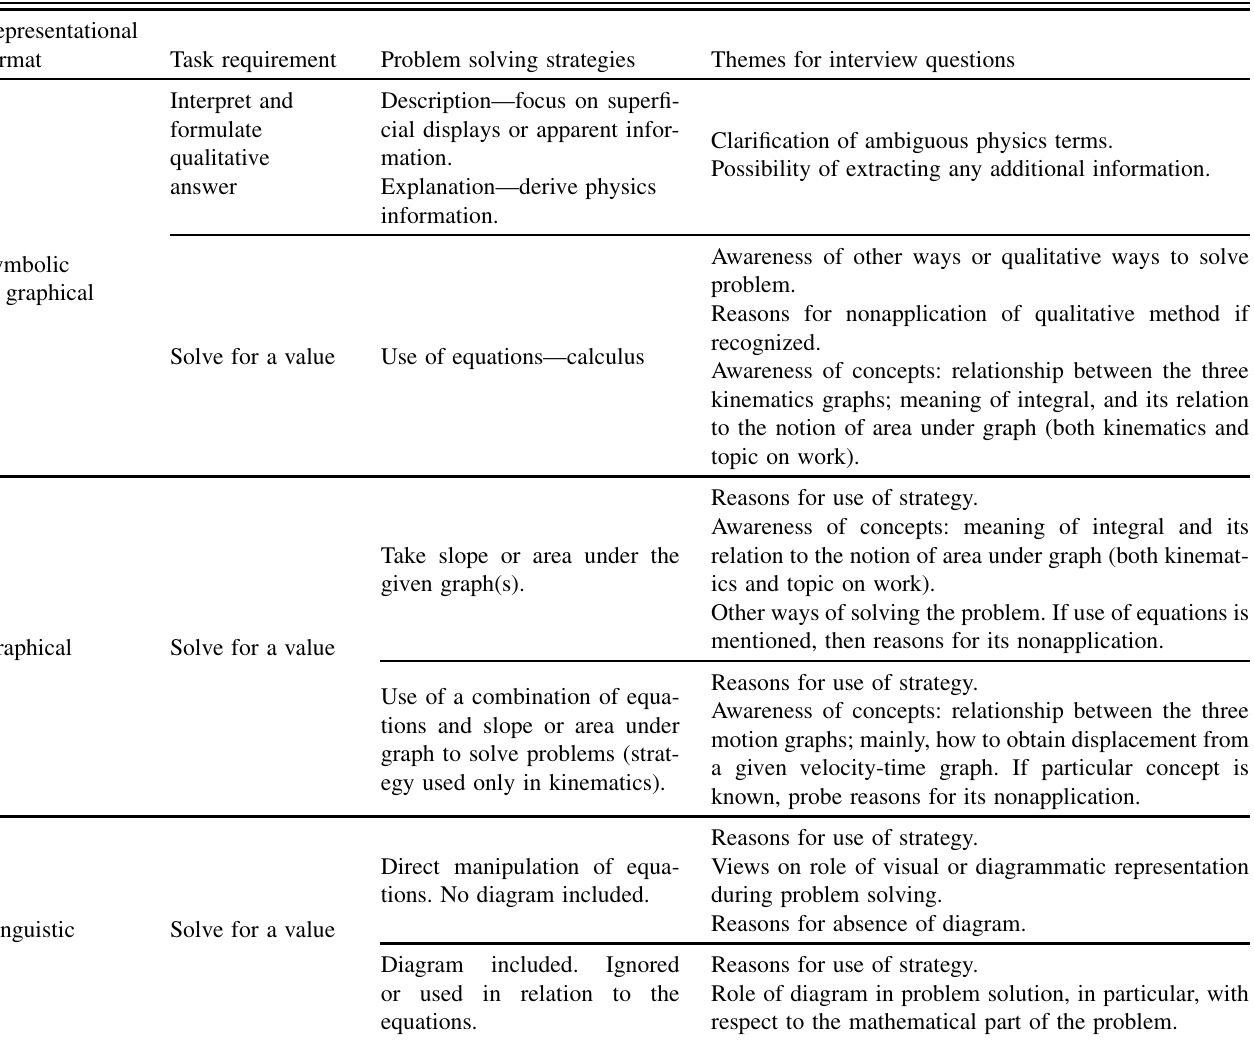
TABLE I. Summary of representational task formats and analysis of students’ actions and reasoning across the topics of kinematics and